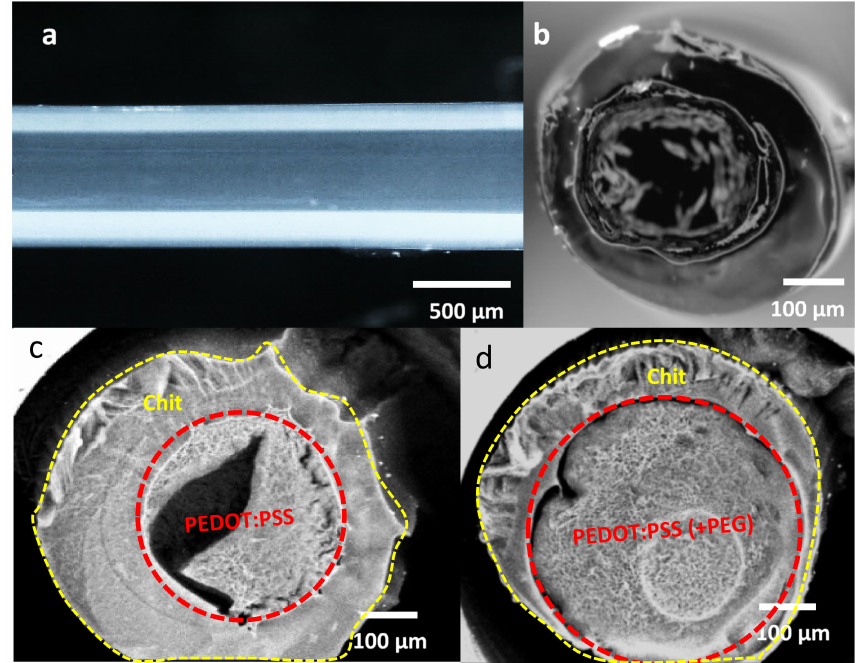
Figure 5. Stereomicroscope images of ( a ) surface and ( b ) cross-sections of Chit-PEDOT fibers, respectively; LV-SEM images of hydrated cross sections of as-prepared Chit-PEDOT fibers ( c ) without and ( d ) with addition of